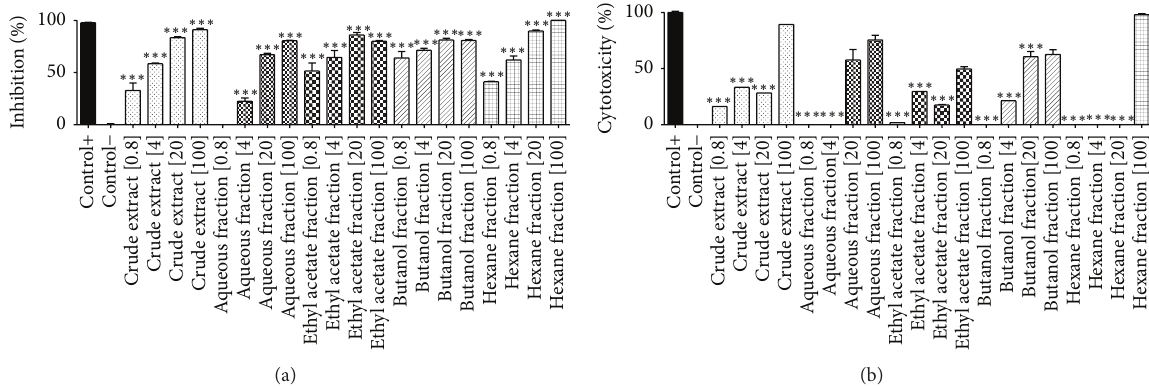
Figure 2: (a) Inhibitory effect of Mycobacterium bovis BCG growth by extracts and fractions of leaves of Ocotea notata tested at four different concentrations,0.8,4,20,and100 𝜇 g/mL.Thepercentageofinhibitionwascomparedwiththepositivecontrol(rifampicin): 98.17±0.8 % / O . D.: 0.180±0.8 and negative control (mycobacteria without treatment) 0.1±0.1 % / O . D.: 0.880±1.24 . (b) Cytotoxicity of the extracts and fractions of leaves of Ocotea notata tested at four different concentrations 0.8, 4, 20, and 100 𝜇 g/mL in murine macrophages RAW 264.7. The percentages were compared to positive control, macrophages treated with Triton 1%: 98.88 ± 1.6/ O . D.: 0.132, and negative control, macrophages without treatment 0.01 ± 0.1/ O . D.: 0.749. ∗ 𝑃 < 0.05 , ∗∗ 𝑃 < 0.01 , and ∗∗∗ 𝑃 < 0.001 , significance obtained by ANOVA and posttest Tukey ( 𝑛 = 3 ), when compared to the negative control (a) and positive control